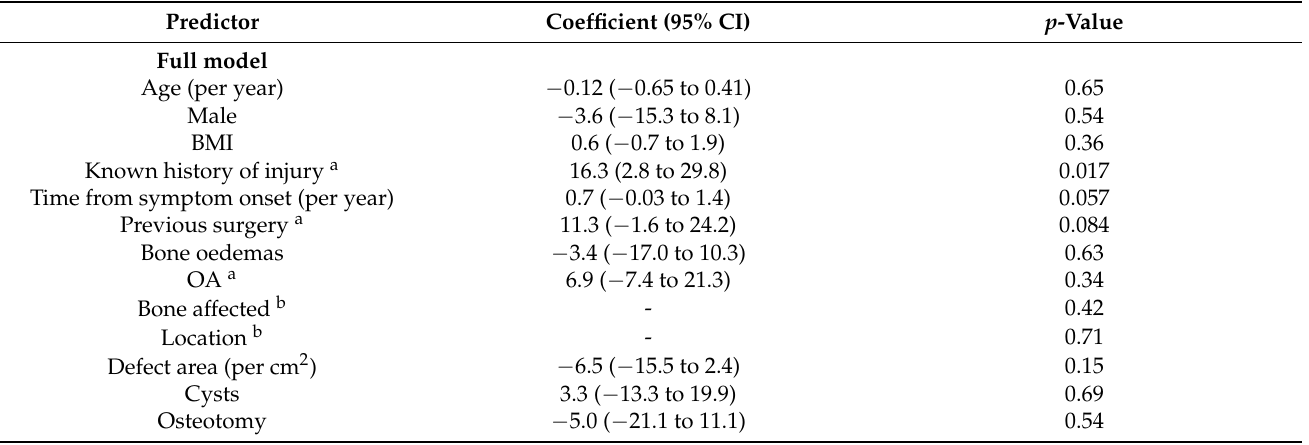
Figure 2. Mean EQ-5D-5L utility value over time. The light shaded area represents the 95% CI band, and the grey dots represent all individual datapoints. Table 5. Predictors of improvement in MOXFQ summary